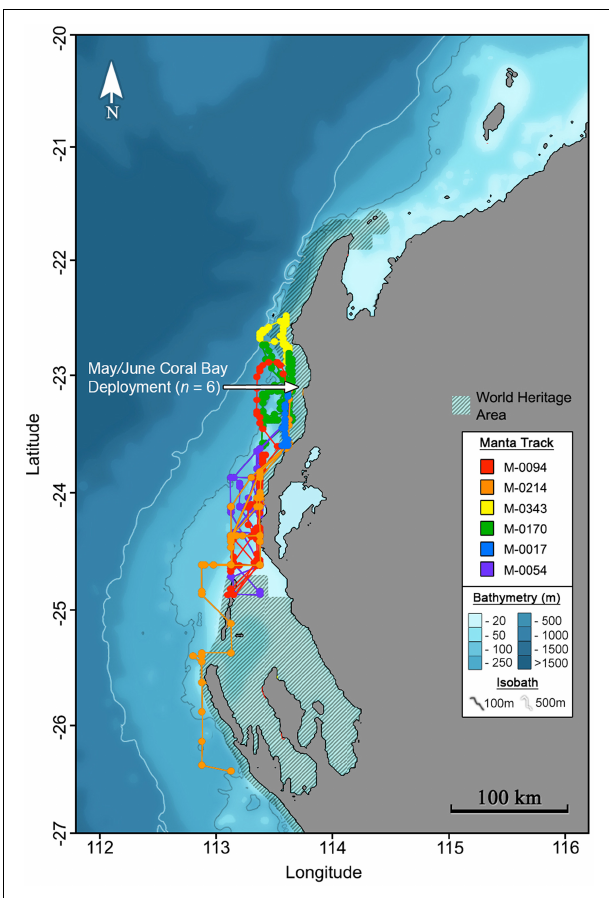
FIGURE 3 | Maximum likelihood tracks for M. alfredi ( n = 6) tagged in the Exmouth Gulf, Western Australia during October 2016. Track points represent 12-hourly maximum likelihood locations from light-based geolocation analysis implemented in the Wildlife Computers Global Position Estimator (v3), and consecutive observations are connected by the shortest straight-line